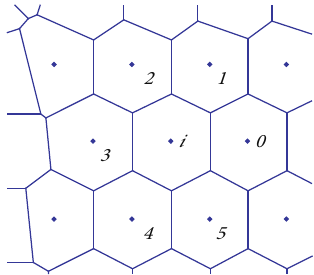
Figure 4: PEBI grid i and its adjacent grids, with adjacent grids numbered 0-5.